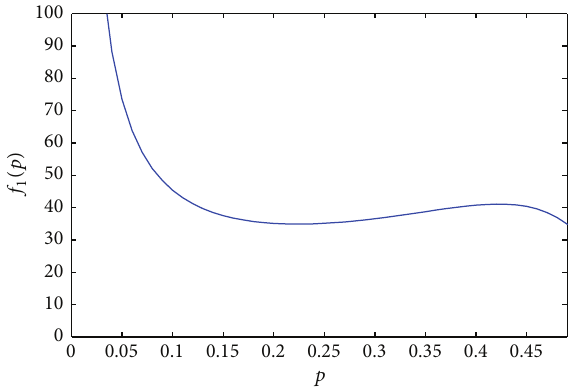
Figure 6: Plot of 𝑓 1 (𝑝) at interval (0,0.4830) .